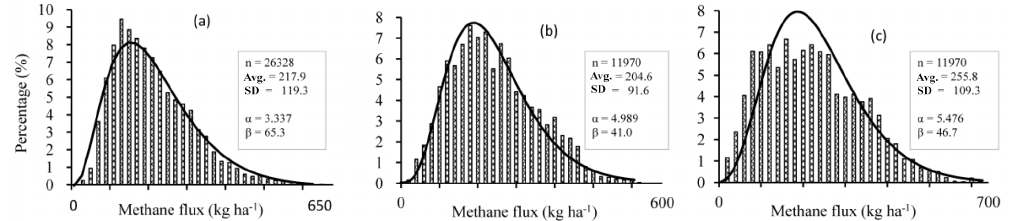
Figure 6. Histograms and their fitting gamma probability lines for the calculated methane fluxes (via CH4MOD) of the 10km × 10km rice paddy grids in China. (a) Single rice rotations, including rice-fallow rotations, and rotations of rice with upland crops; (b) early and (c) late rice in double rice rotations. The vertical bars are the histograms of the calculated F j (Eq. 5), and the solid line is the theoretic gamma PDF line, the parameters for which were derived from the statistics for F j via momentum